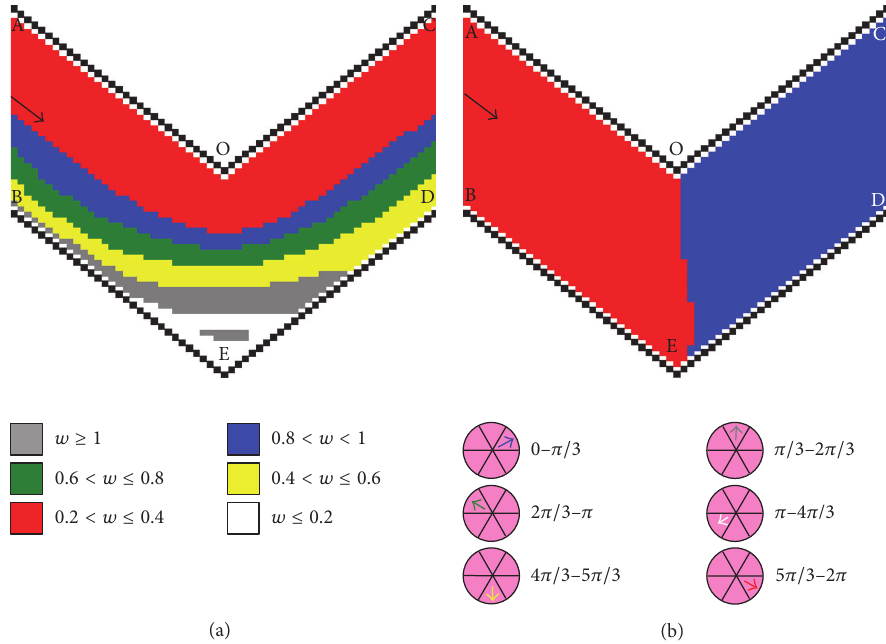
Figure 13: Computational 2D diagrams for the absolute value of dimensionless flow velocity 𝑤 (a) and for directions of the vectors of dimensionless flow velocity w (b) for the viscous flow of a plasticine workpiece model through obtuse-angled equal channel angular dies AOC–BED of Segal geometry (a, b) with channel intersection angles ∠ (AOC) = 2 𝜃 = 105, where the inlet AB is at the left and the outlet CD is at the